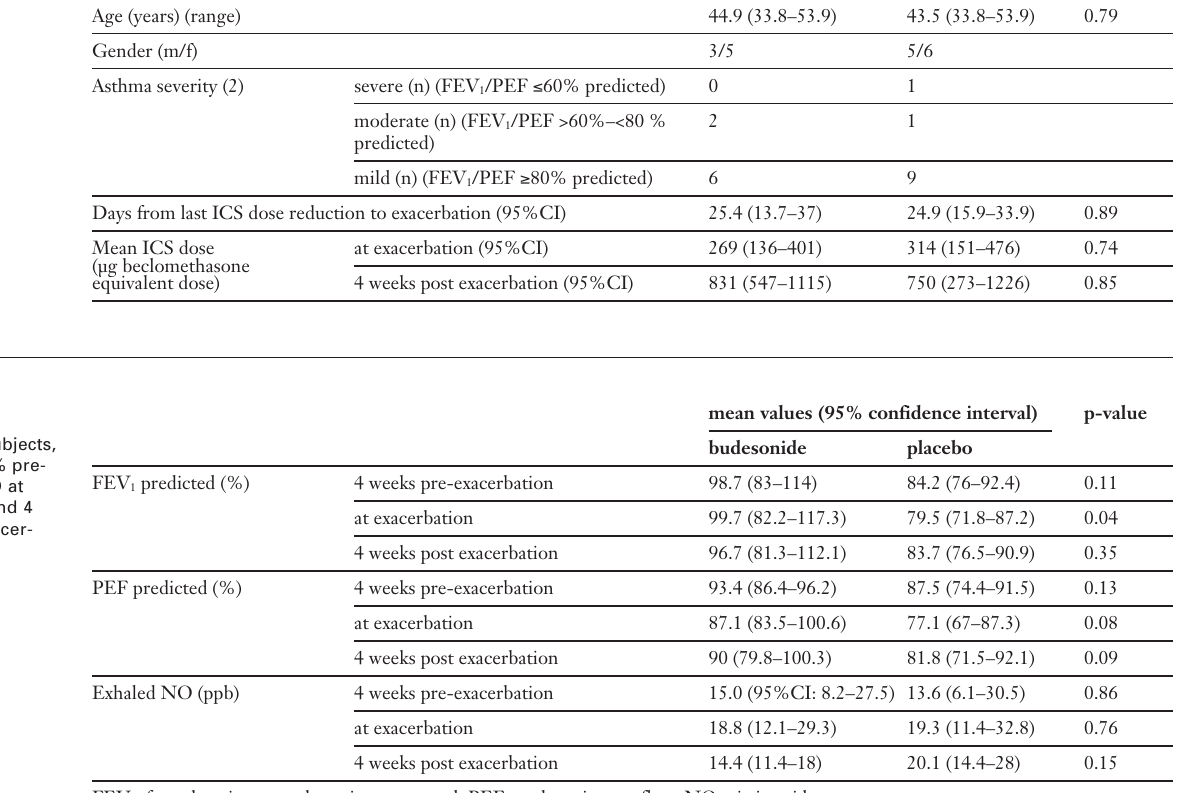
Subject charac- teristics of the 19 subjects.